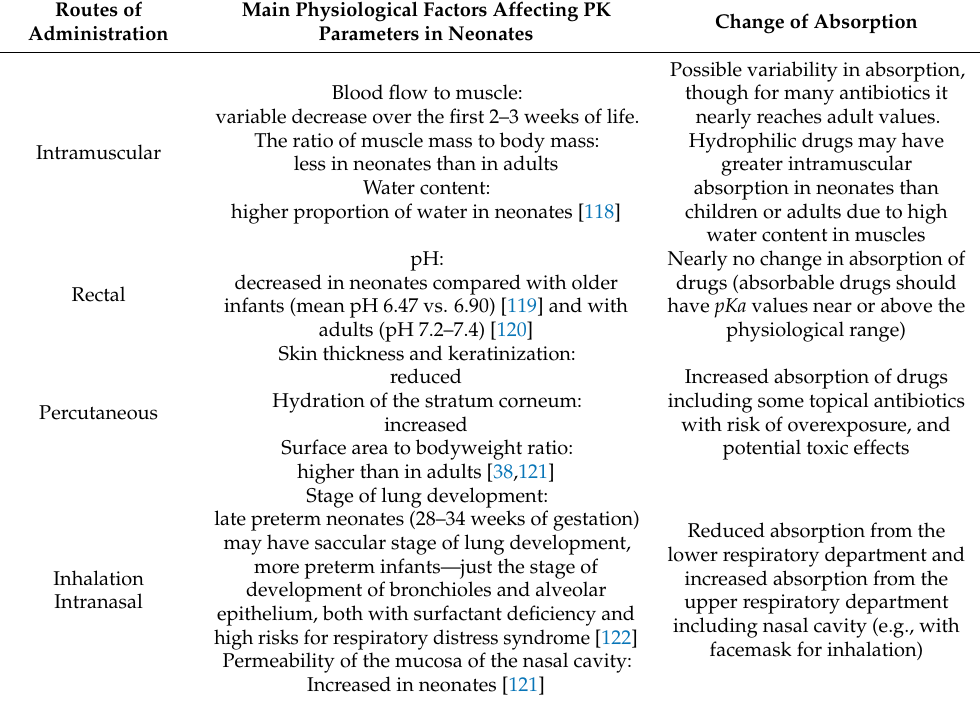
Table 4. Age-associated change of absorption for non-oral routes of drugs